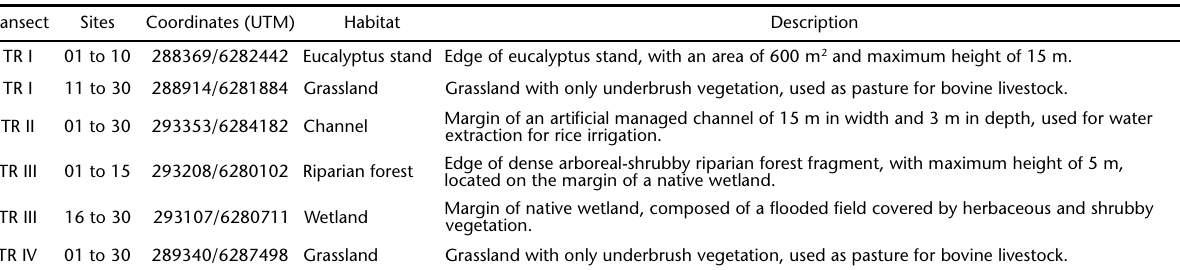
Grassland with only underbrush vegetation, used as pasture for bovine